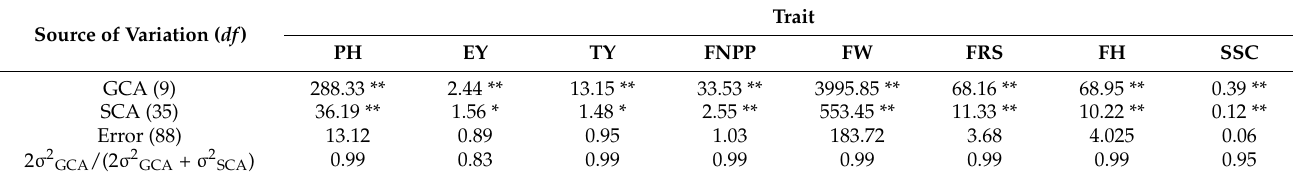
Table 4. Analysis of heritability of and variance in combining ability for different traits. Source of Variation ( df